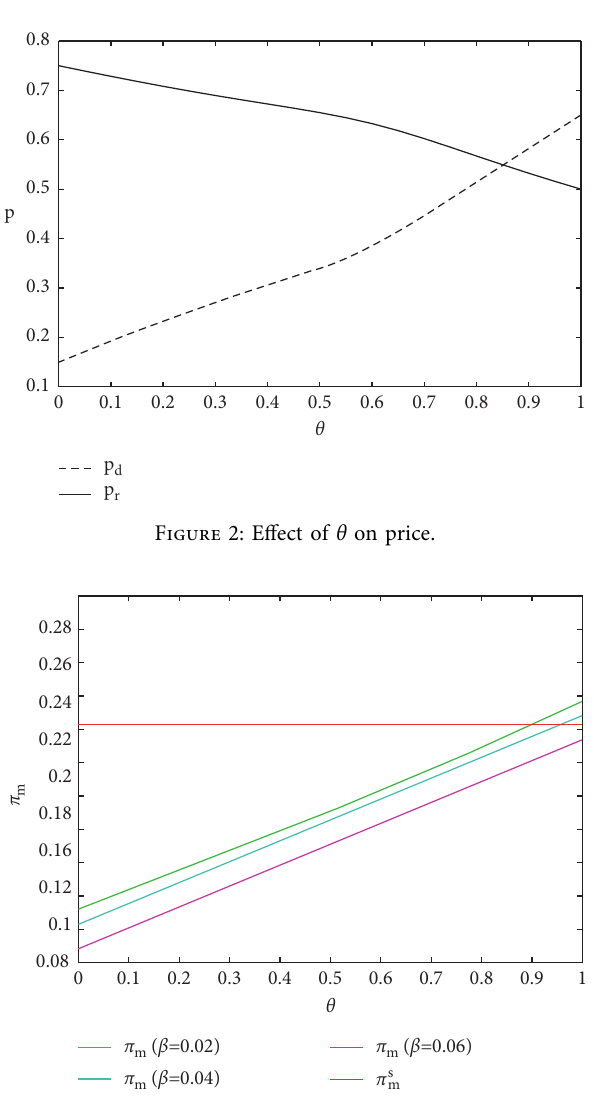
Figure 3: Effect of θ on the manufacturer’s profit in the dual-channel supply chain adopting blockchain.